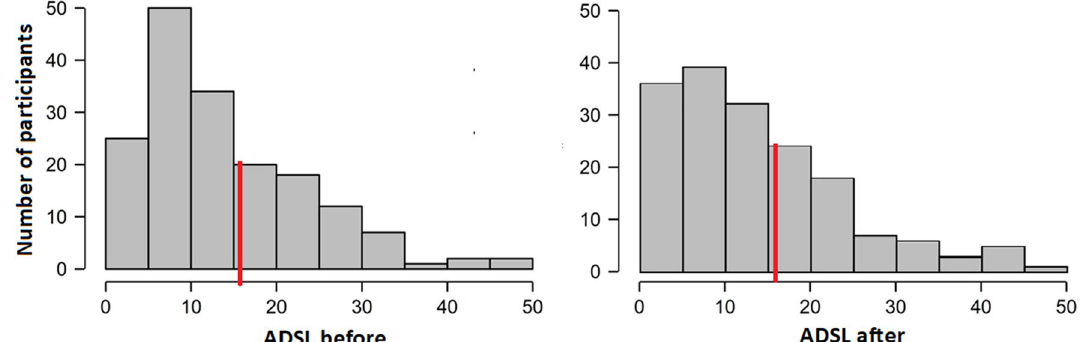
Figure 1. Density of results in ADSL scale in the first (before) and the second (after) measure. The red line indicates a turning point for depression 38 .